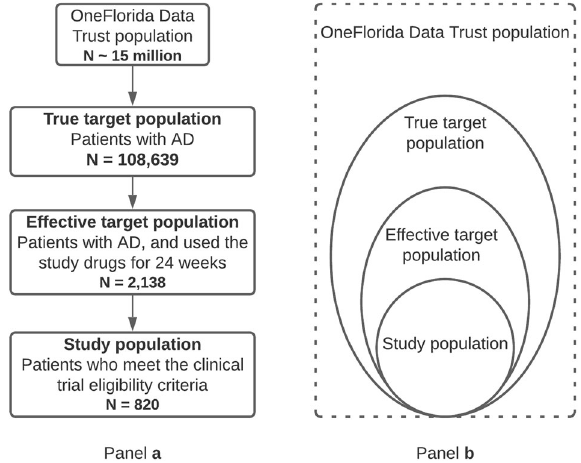
Fig. 1 Work fl ow implemented to select the target, study, and trial not eligible populations are selected from the OneFlorida Data Trust. Panel a shows thede fi nition of different population, and number of patients identi fi ed. Panel b shows the relationships between the target, study, trial not eligible, and entire OneFlorida Data Trust populations. The cohort identi fi cation process for the target, study, and trial not eligible